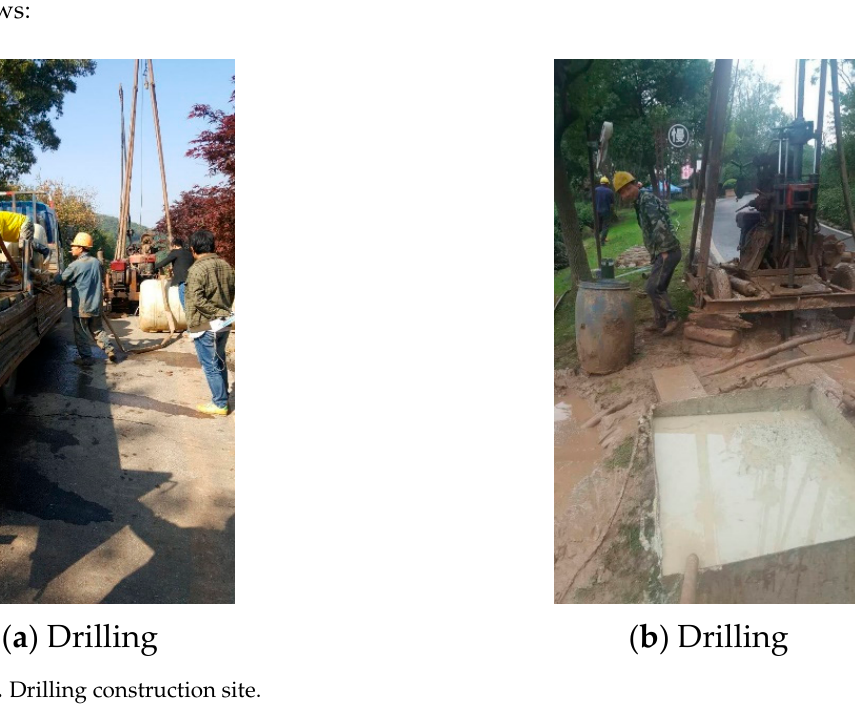
(a) Mapped by high-density electrical method (b) Mapped by audio-frequency magnetotelluric method Figure 8. Geophysical section of 1 − 1.